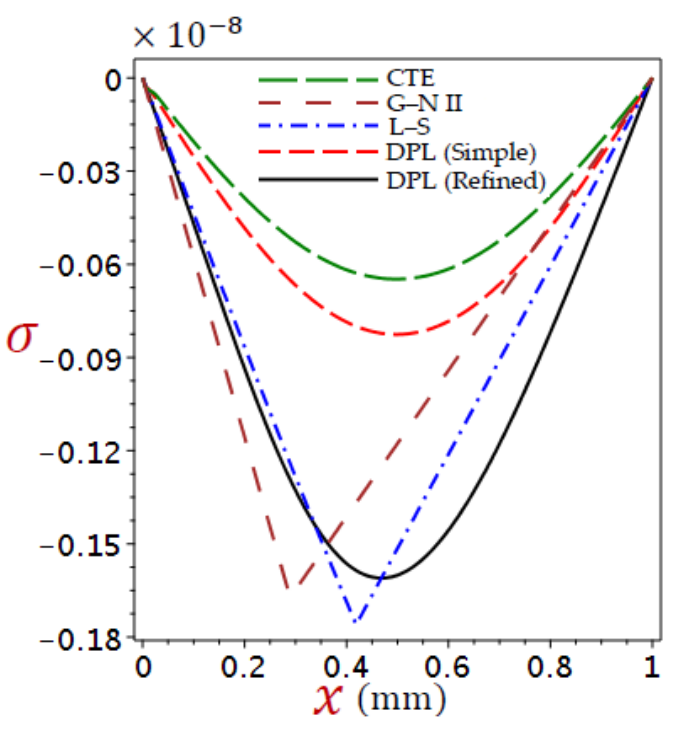
Figure 5. Comparison of variation of stress (𝜎) across the skin tissue utilizing numerous theories.